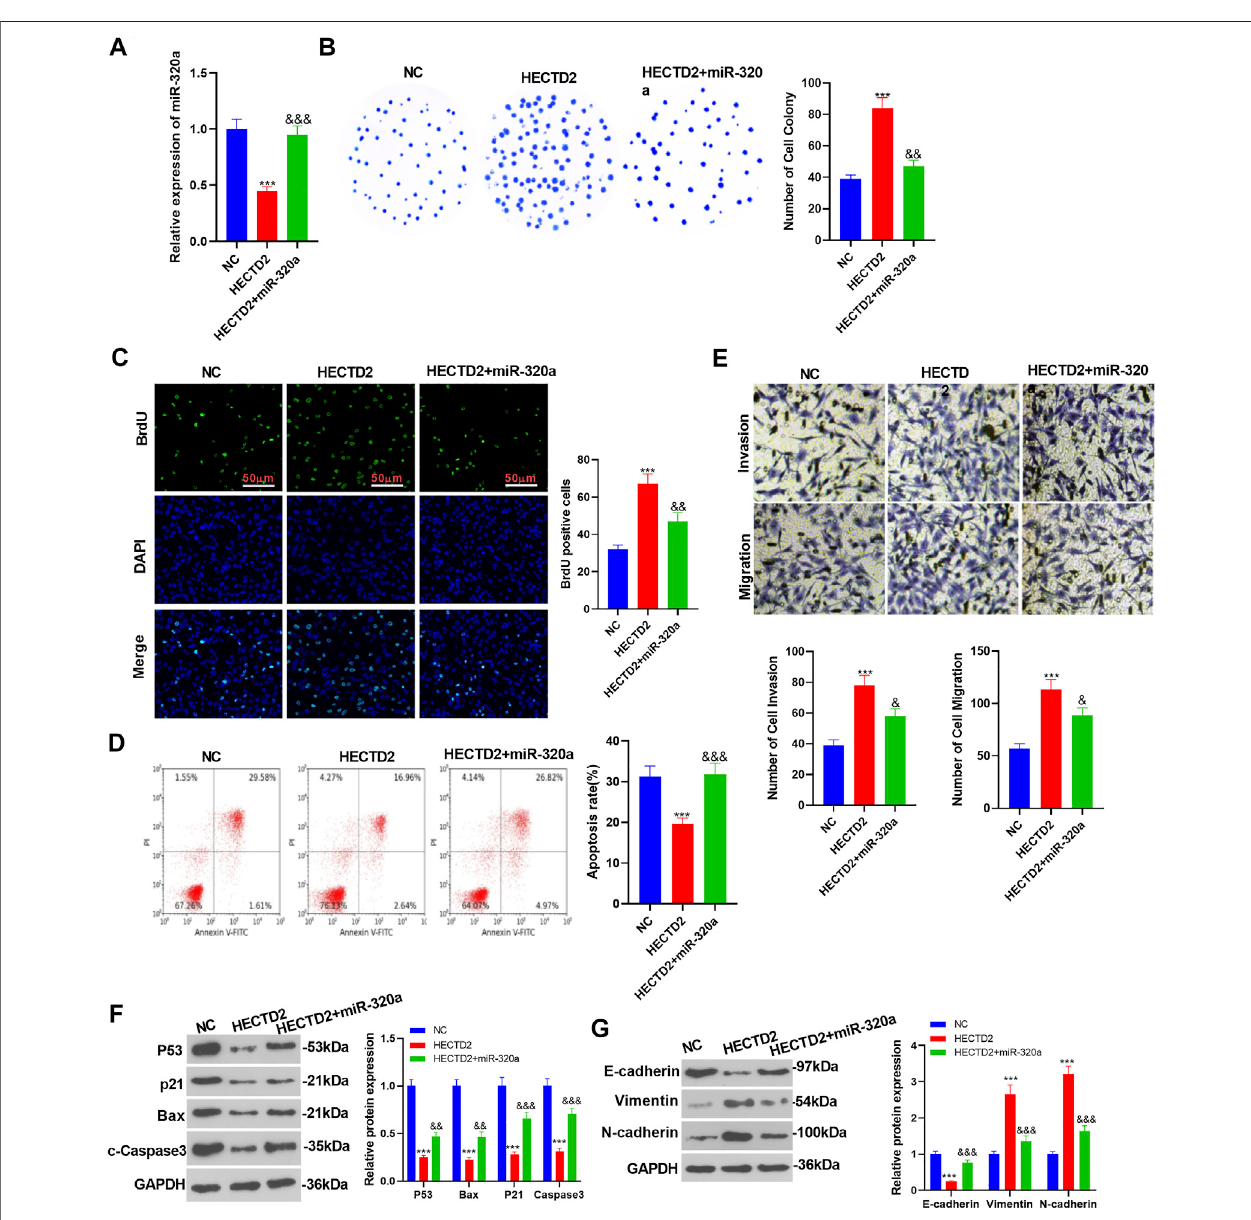
FIGURE 8 | miR-320a affected RCC growth and EMT via HECTD2. Transfection of miR-320a mimics was made in 786-O cells with overexpressed HECTD2. (A) . RT-qPCR was implemented to examine miR-320 expression. (B – D) : The colony formation assay, BrdU assay, and fl ow cytometry were applied to assess RCC cell proliferation and apoptosis. RCC cell migration and invasion were tested by Transwell assay. (F,G) : The pro fi les of P53, Bax, p21, c-Caspase3, E-cadherin, Vimentin, and N-cadherin were compared by Transwell assay. *** p < 0.001, & p < 0.05, && p < 0.01, &&& p < 0.001. N (cid:2) 3.